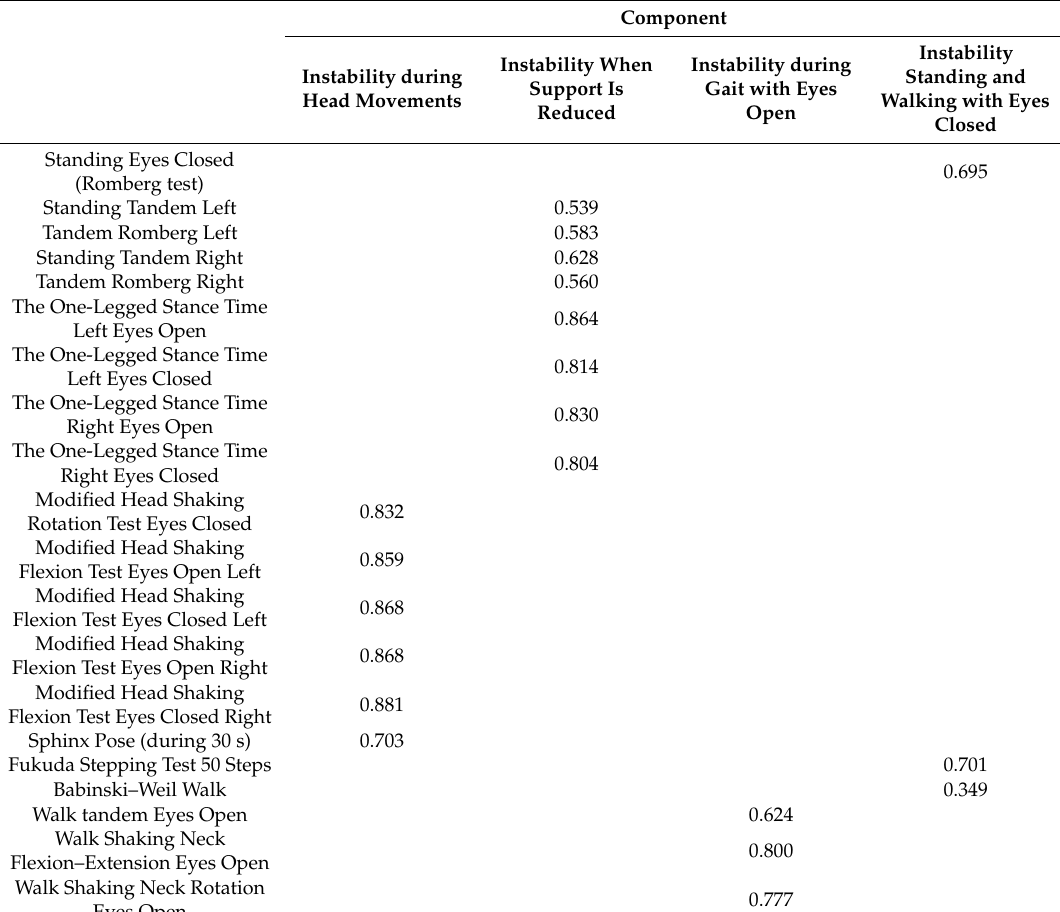
Table 3. Rotated component matrix of the 20-item JAEN screening tool obtained by principal component analysis with Varimax